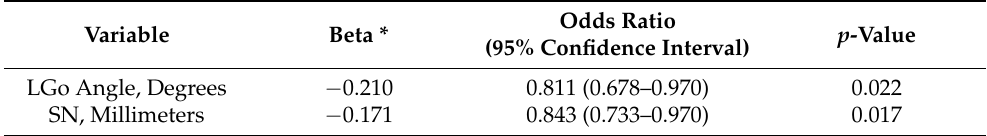
Table 6. Multivariate logistic regression analysis: predictors for treatment outcome of a tongue- beaded oral appliance.